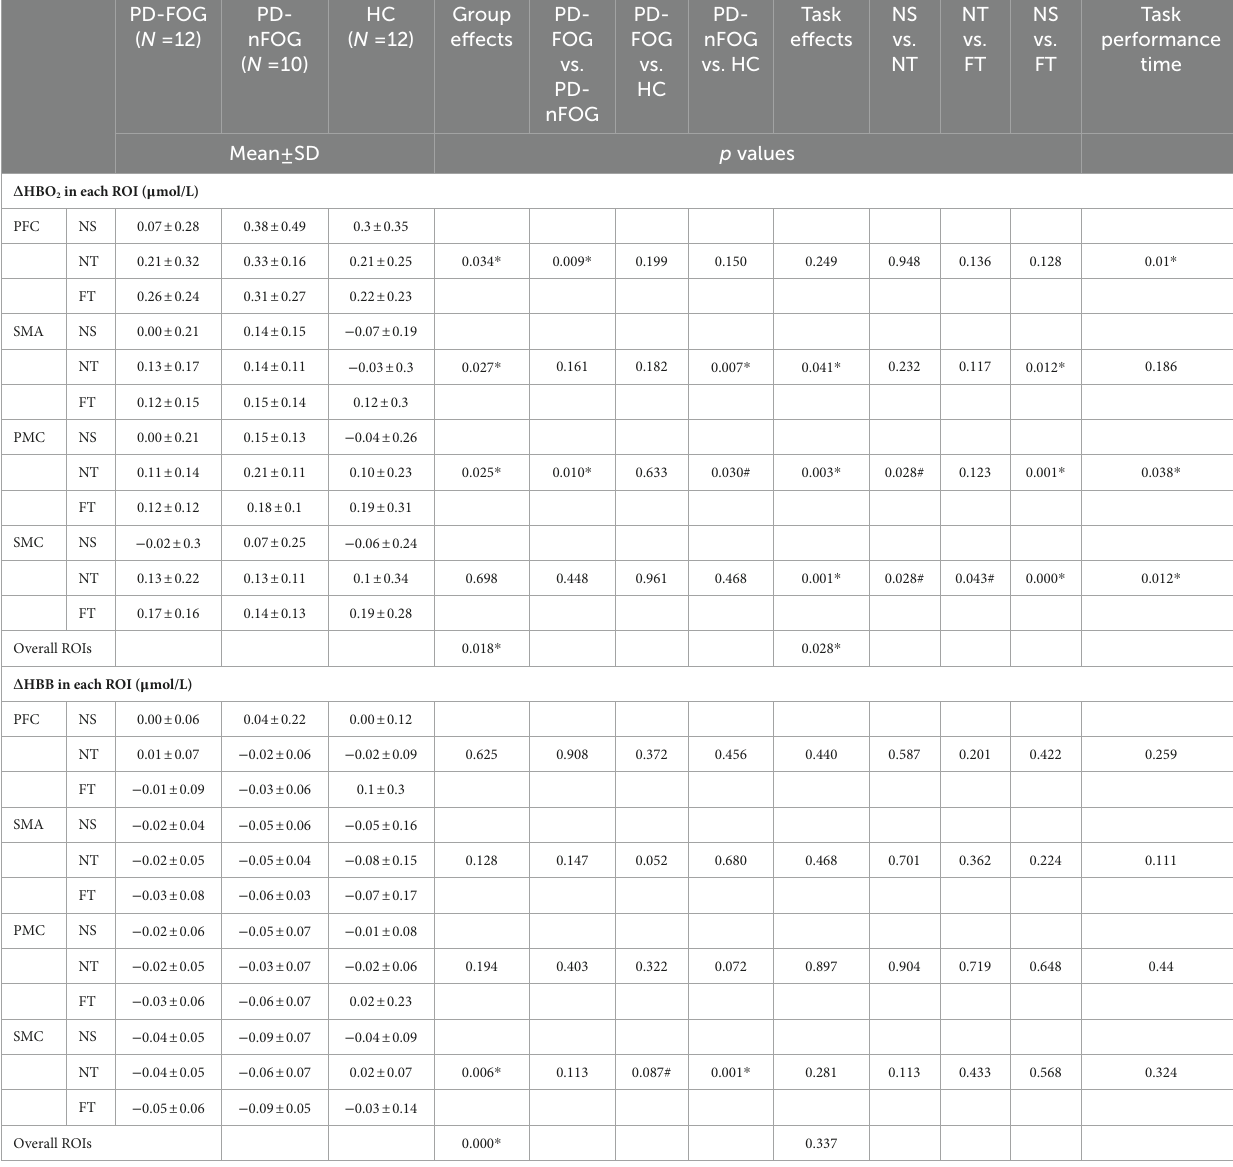
TABLE 4 Two-way ANOVA results of haemodynamic responses of ROIs during different tasks among the PD-FOG, PD-nFOG, and HC